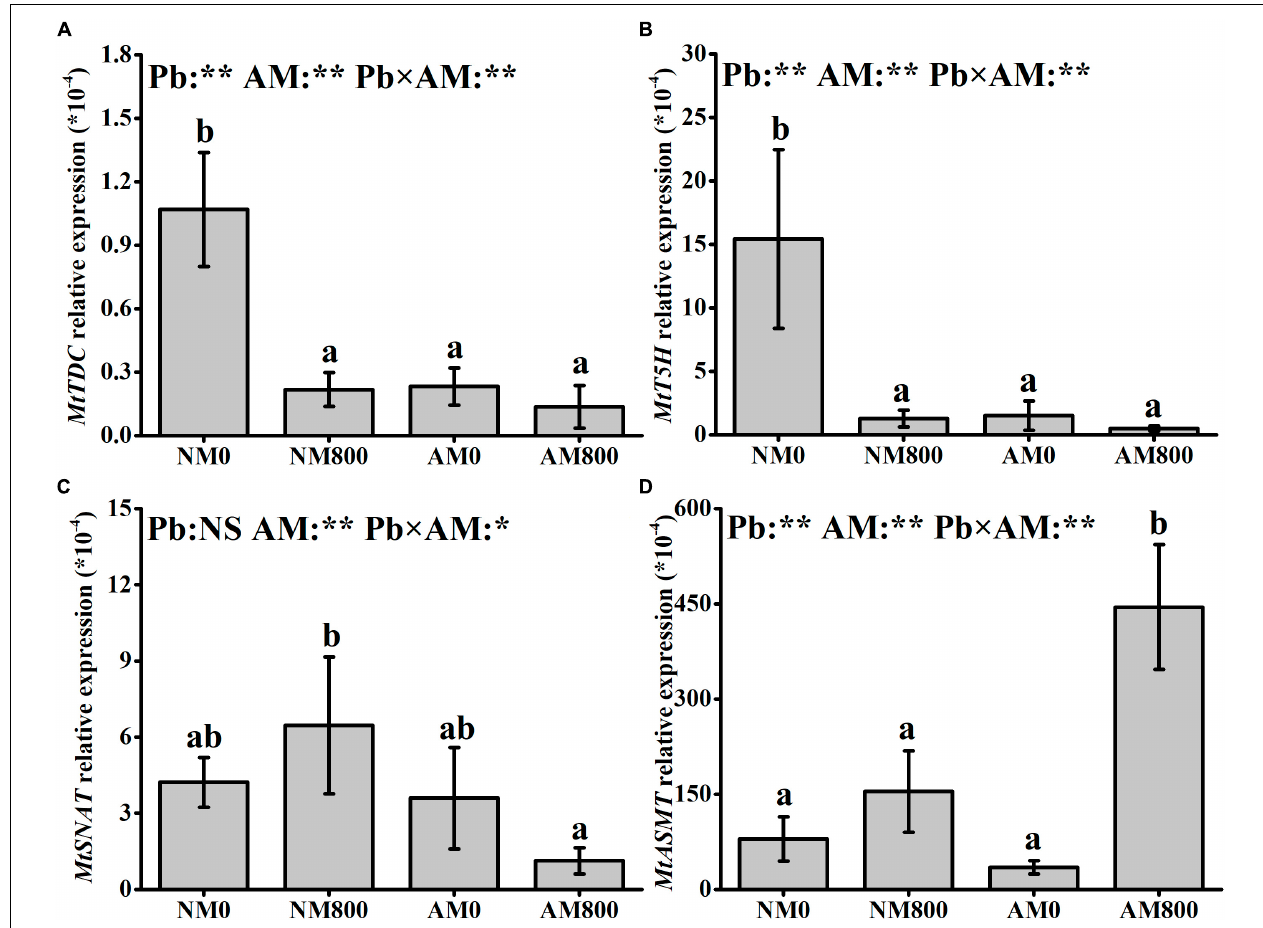
FIGURE 2 | (A–D) The relative expression of MtTDC , MtT5H , MtSNAT and MtASMT of AM roots under Pb stress. The data are the means ± standard deviation ( n = 4). Different letters above the columns indicate significant difference among the means of melatonin synthesis-related genes expression by Tukey HSD’s test ( P < 0.05), * P < 0.05, ** P < 0.01; NS, not significant. The abbreviation is consistent with the